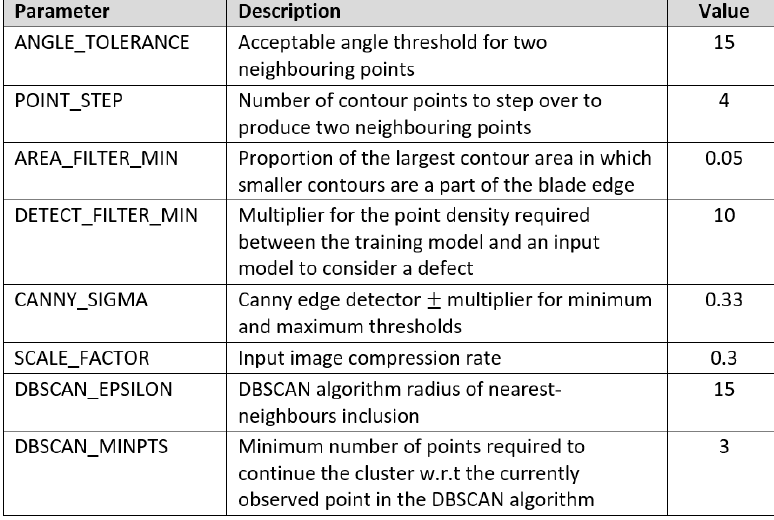
Figure 16. Algorithm parameters.